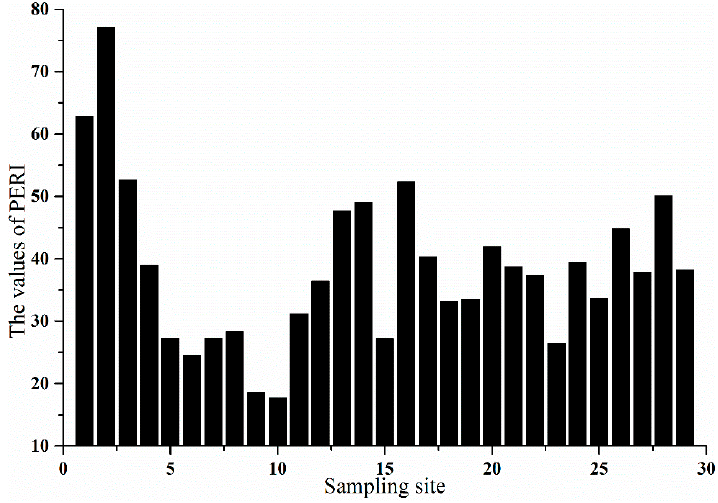
Figure 4. The values of potential ecological risk index (PERI) in different sampling sites.